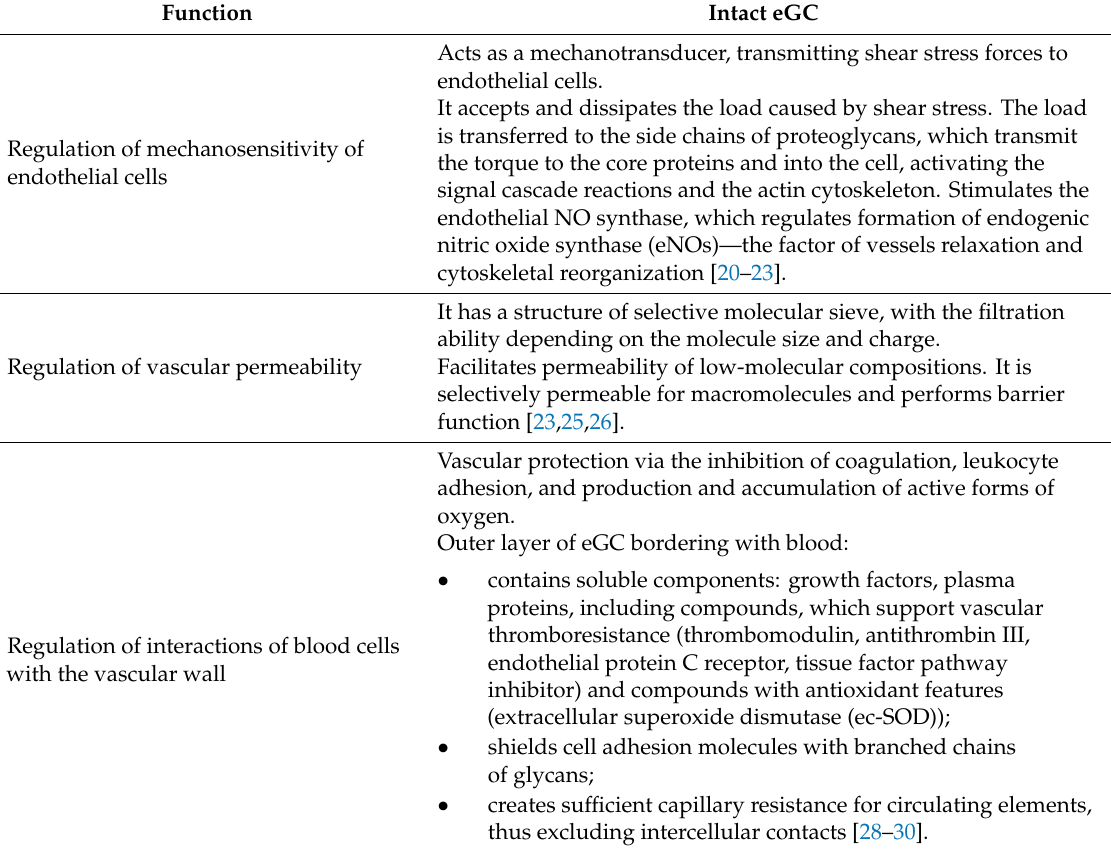
Table 1. Regulatory role of endothelial glycocalyx in physiological and pathological